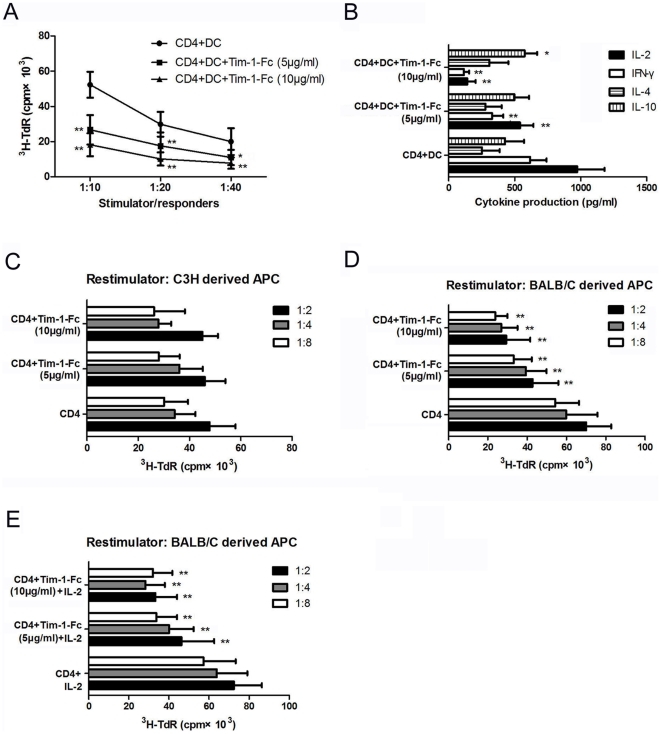
Tim-1-Fc inhibits allo-MLR and induces T cell hyporesponsiveness.CD4+ T cells (2×105/well) were cocultured with BALB/C derived DCs at indicated ratios (1∶40, 1∶20, 1∶10) for 72 h, Tim-1-Fc (5, 10 µg/ml) was added to the culture at the beginning. Cell proliferation and cytokines production were evaluated by 3H-thymidine incorporation (A) and ELISA (B). C57BL/6 splenic CD4+ T cells (2×105/well) were incubated at a fixed stimulator:responder cell ratio (1∶10) with irradiated allogeneic DCs in primary MLR. After three days, DCs were removed by autoMACS selection of H-2d cells. The CD4+ T cells were rested in culture medium for a further two days, and then restimulated with irradiated C3H (H-2k, third-party) splenocytes (C), BALB/c derived splenocytes (D), or plus 20 IU/ml IL-2 (E) for 72 h (secondary MLR) at different stimulator:responder cell ratio. Cell proliferation was determined by 3H thymidine incorporation. *P<0.05, ** P<0.01 from the group without Tim-1-Fc treatment.